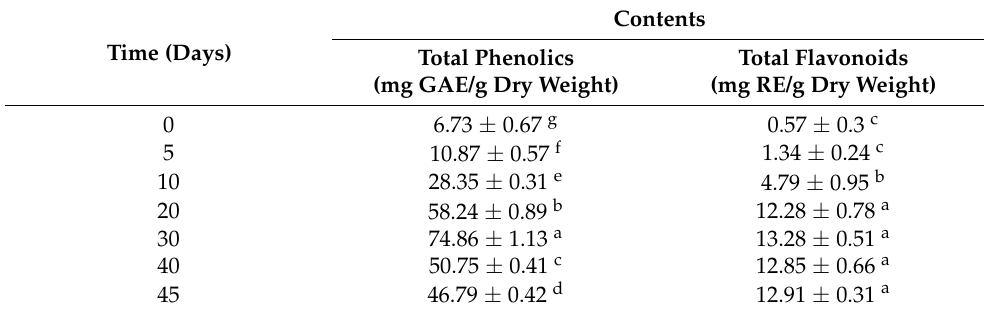
Table 2. Total phenolics and total flavonoids contents of hot-water extracts obtained from fresh garlic and black garlic with different aging